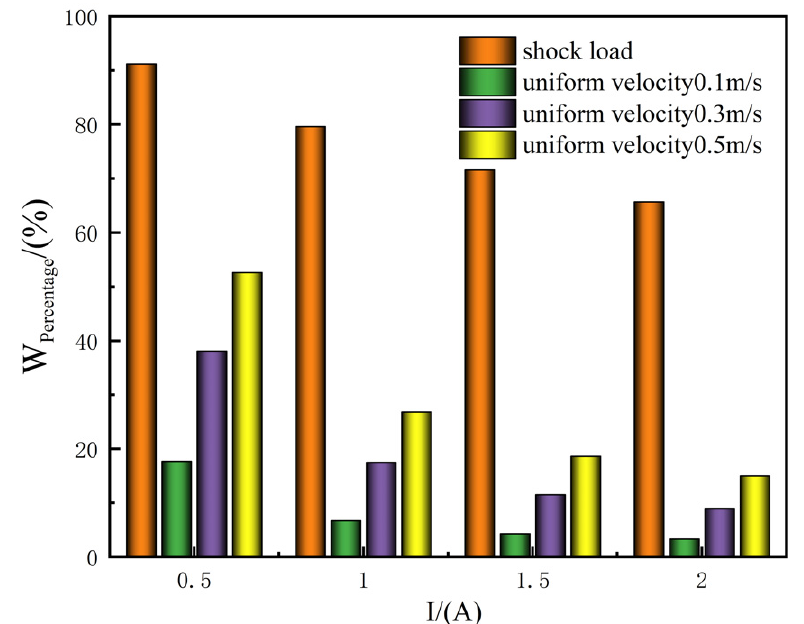
Figure 15. Impact energy consumption ratio of viscous damping force under low-velocity vibration and impact conditions.